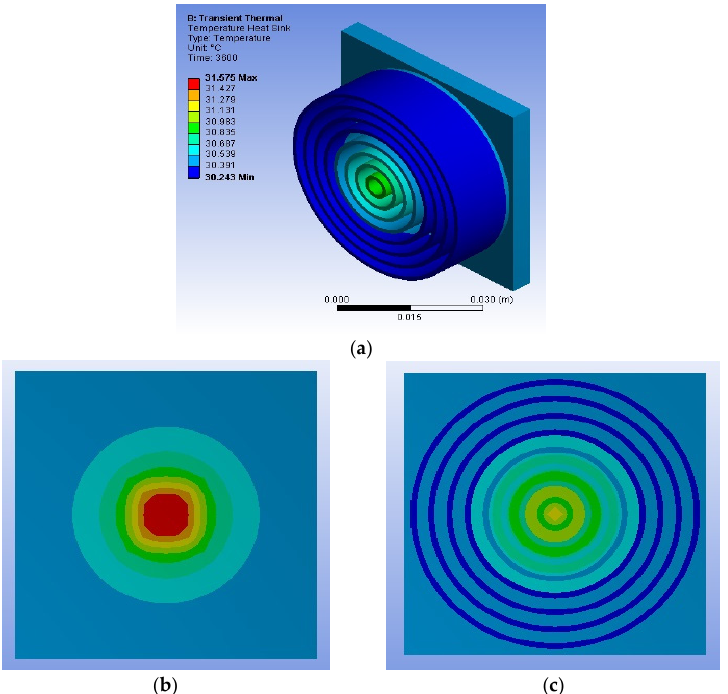
Figure 3. Temperature contour plot at 4.55 W: ( a ) Isometric view of the heat sink, ( b ) Back view of the heat sink, and ( c ) Front view of the heat sink.